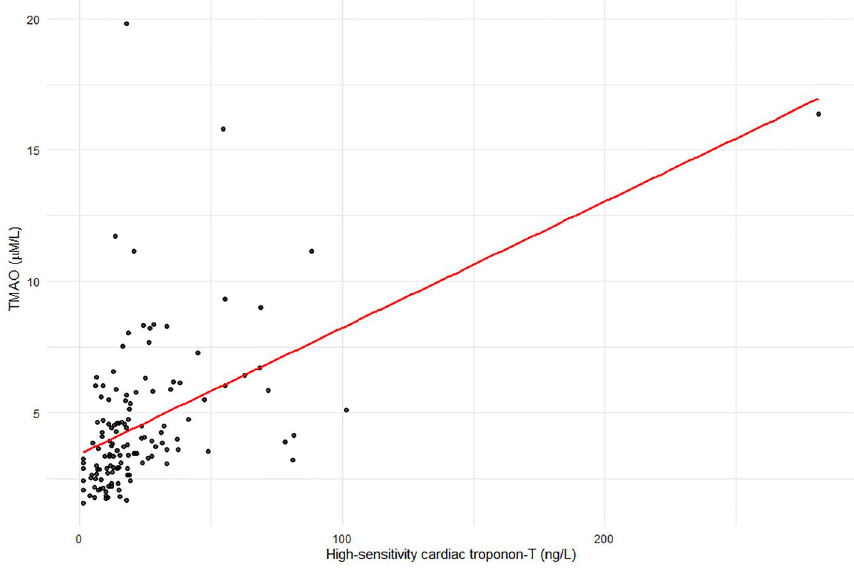
Figure 1. Correlation between plasma TMAO levels and high-sensitivity cardiac troponin-T.